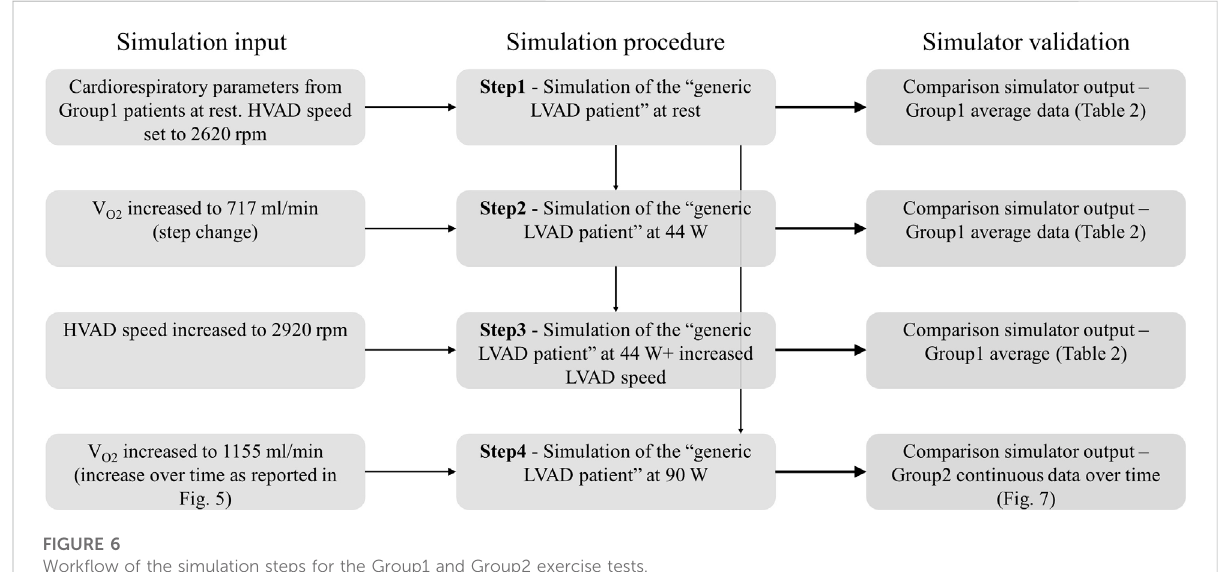
FIGURE 6 Work fl ow of the simulation steps for the Group1 and Group2 exercise